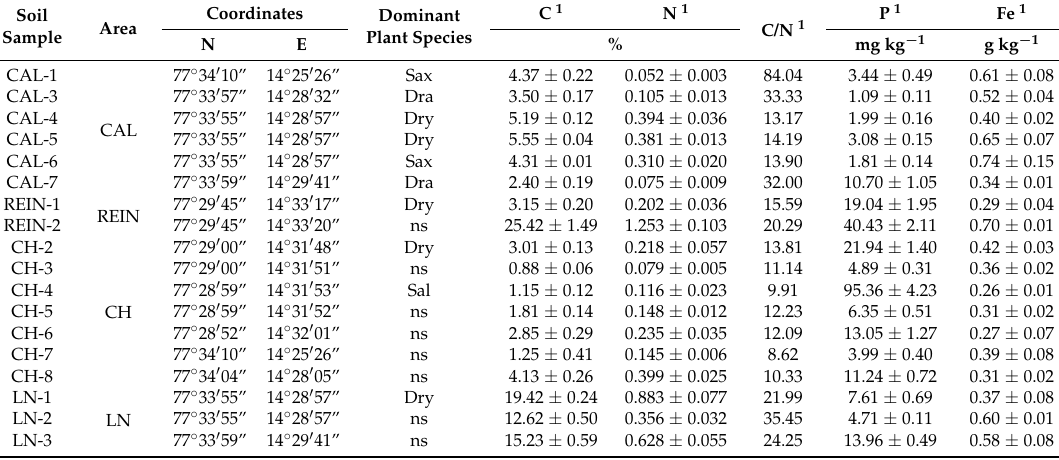
Table 2. The sampling sites of NW part of Wedel Jarlsberg Land (Spitsbergen, Svalbard) with plant species occurring in particular areas. Abbreviations: CAL = Calypsostranda; REIN =